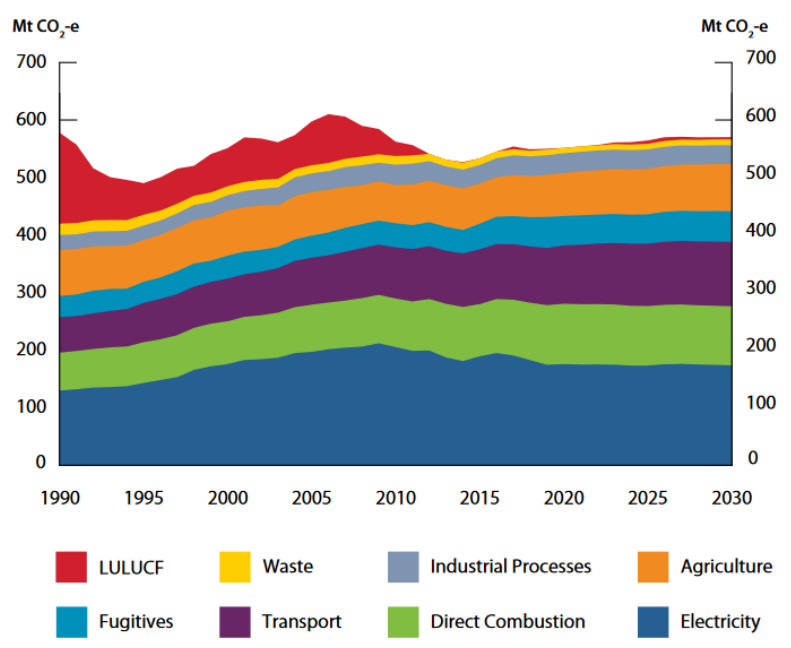
Figure 3. Overall GHG emissions from different sectors in Australia